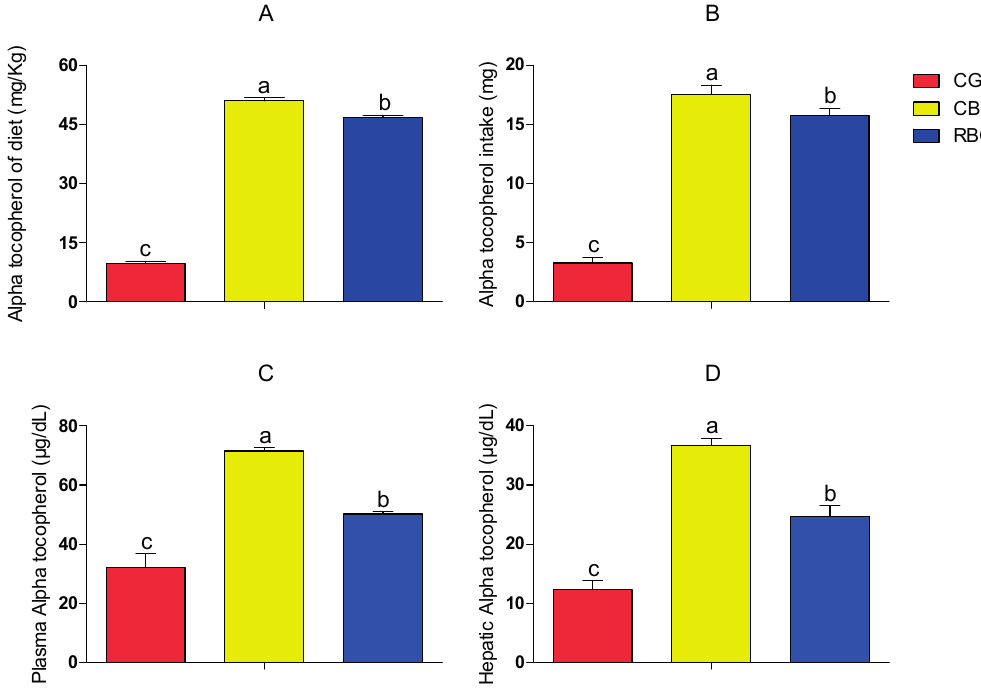
Figure 2. Content and intake of alpha tocopherol of diets and serum and hepatic alpha tocopherol of Wistar rats fed with diets added of soybean oil or refined or crude buriti oil. Panel A : alpha tocopherol of diet; Panel B : alpha tocopherol intake; Panel C : Plasma alpha tocopherol level; Panel D : Hepatic alpha tocopherol level. Means followed by different letters indicate significant difference with error probability p < 0.05, according to the Tukey test. Abbreviations: Groups: CG = control group with AIN-93G diet; CBO = experimental group with AIN-93G diet with crude buriti oil; RBO = Experimental group with AIN-93G diet with refined buriti